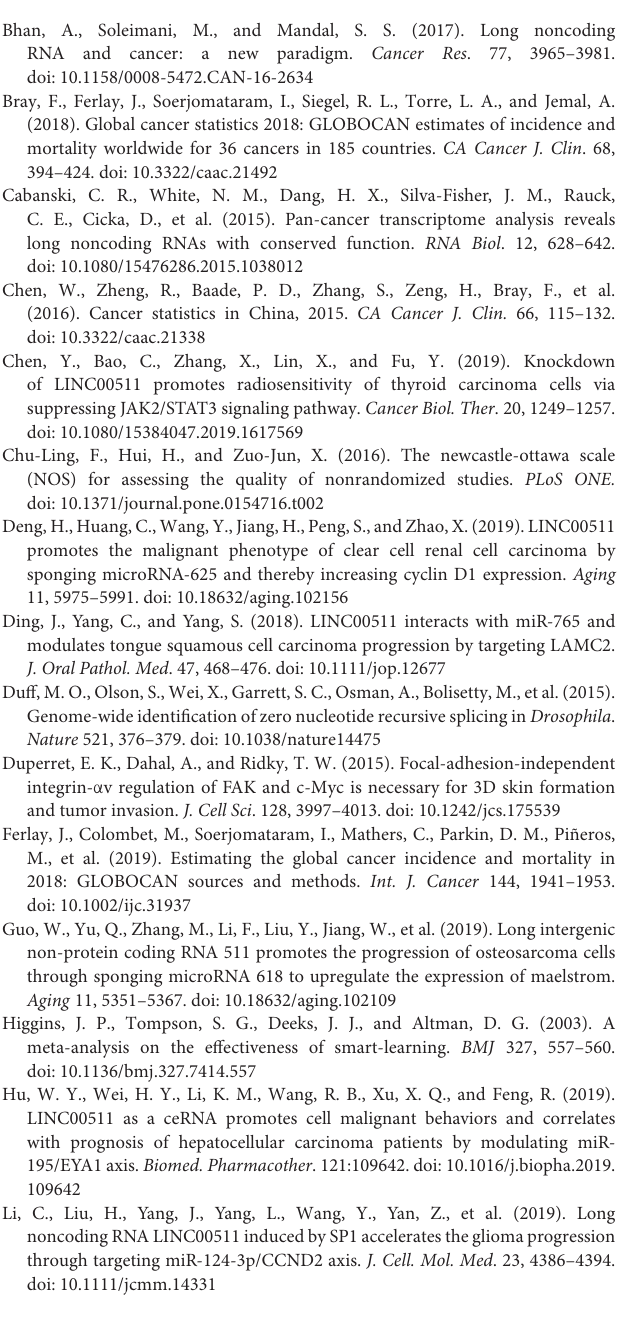
Figure S2 | Forest plot of LINC00511 expression and OR for clinicopathological features. The investigated clinicopathological parameters are (A) gender, (B) age, (C) clinical stage, (D) tumor size, (E) differentiation, (F) LN metastasis and (G) distant metastasis. Figure S3 | Funnel plot for the meta-analyses of clinical. Table S1 | Detailed search strategies. Table S2 | The results of this meta-analysis and subgroup analyses for overall